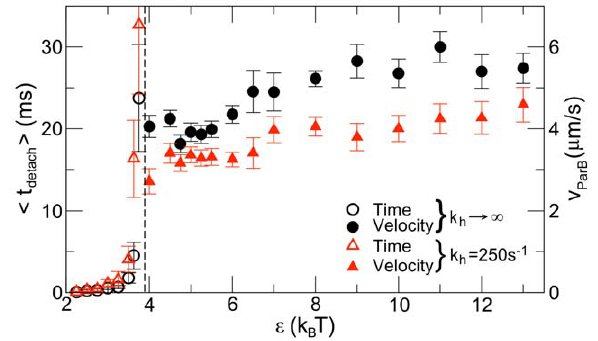
Figure 4. Dependence of translocation velocity on ParB–ParA binding energy. ParB detaches in an observably short time, S t detach T , when the binding energy, E , is too small (open symbols). When E is large enough, v ParB (solid symbols) is non-zero, and is insensitive to E over the observed range for both fast (black) and slow (red) k h . The dashed line separates regimes of detachment and